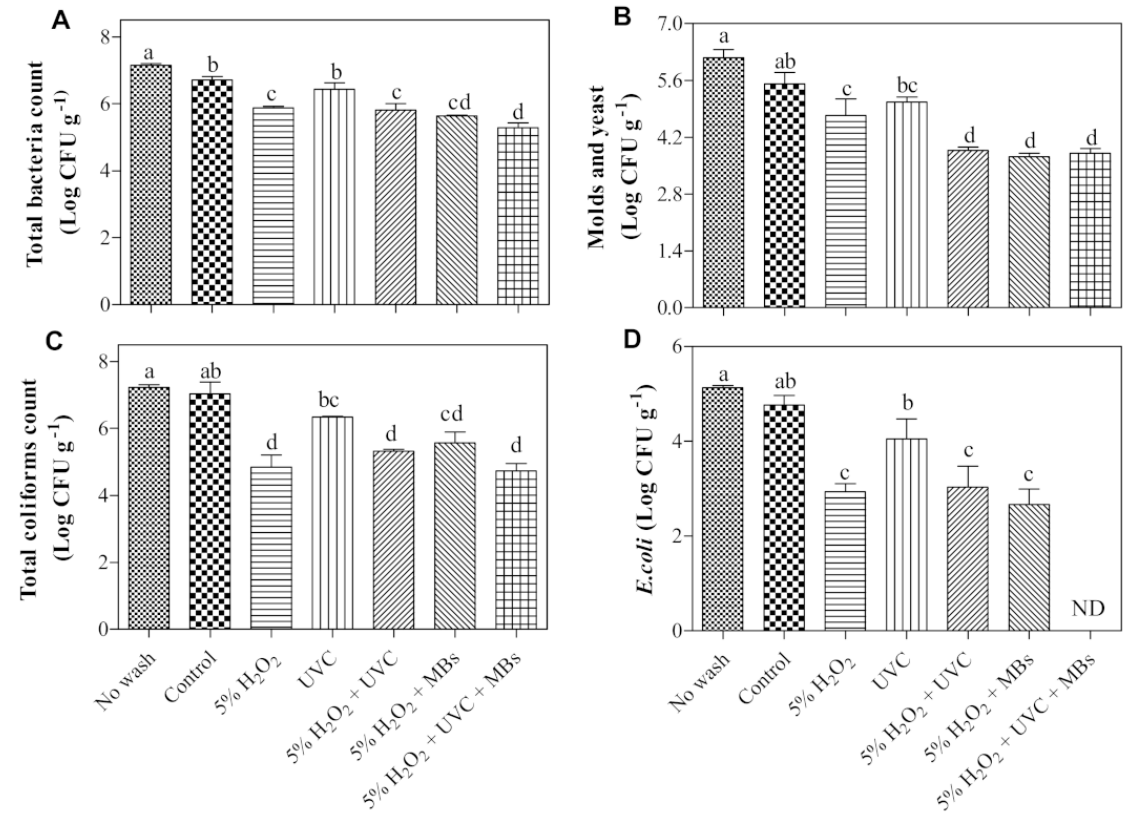
Figure 2. Effects of seed decontamination treatments on ( A ) total bacteria count, ( B ) molds and yeast count, ( C ) total coliforms count, and ( D ) Escherichia coli count in roselle seeds for microgreen production. Data are means of four replicates ± SE. Means with the same letter are not significantly different at p ≤ 0.05 by the DMRT test. ND = not detected.